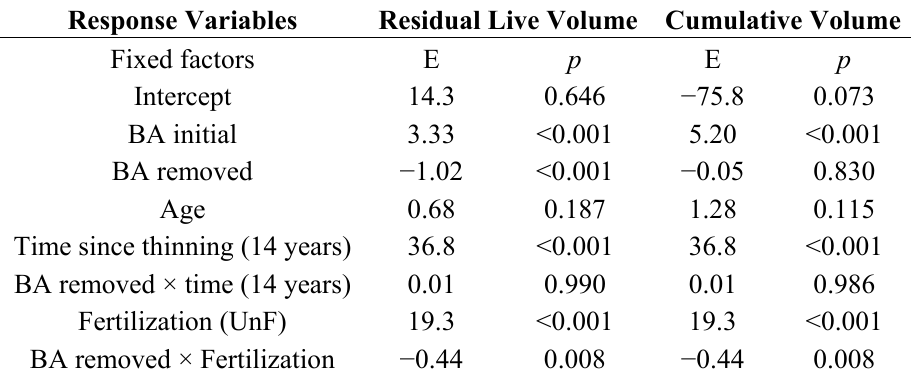
Table 5. Changes in merchantable stand volume induced by commercial thinning and fertilization in jack pine stands over a period of 14 years. Fertilization was conducted within experimental sub-plots 3 to 5 years after thinning. Effects of initial stand basal area and age, basal area removed by commercial thinning, fertilization, time since thinning and selected interactions assessed by means of linear mixed models.